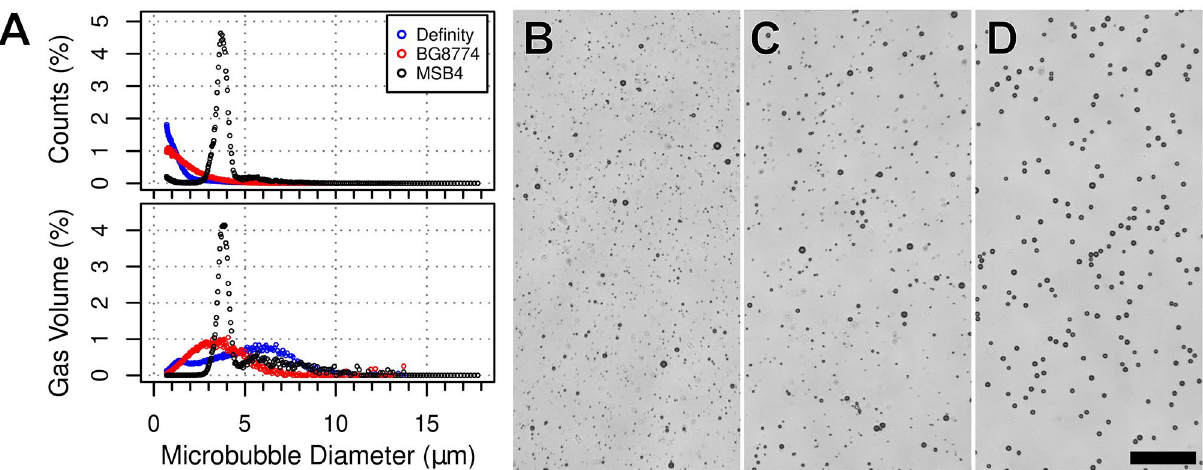
Figure 1. Microbubble size distribution. ( A ) Relative distribution of microbubble count and gas volume are displayed for each formulation. Definity and BG8774 exhibited polydisperse size distributions, each with more than 80% of microbubbles measuring less than 2 μm in diameter. MSB4 displayed a monodisperse size distribution, with approximately 85% of microbubbles measuring between 3 and 5 μm in diameter.